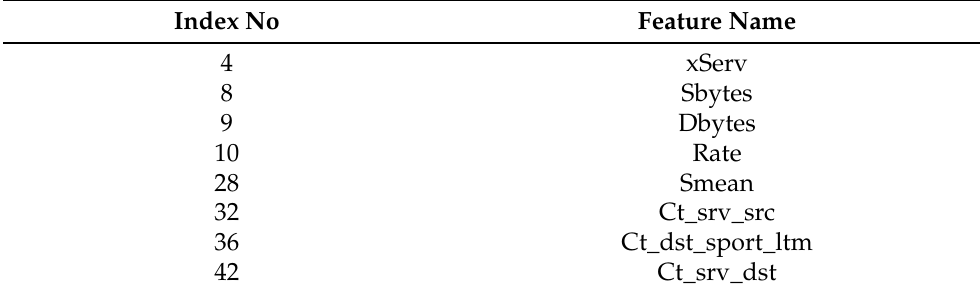
Table 2. Identified features for UNSW-NB15 dataset.